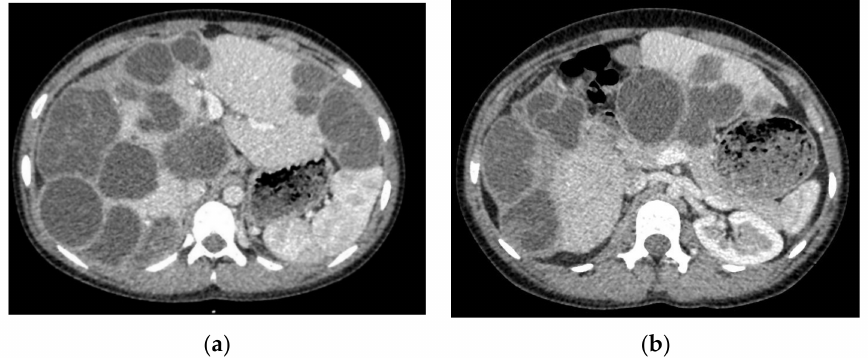
Figure 5. Abdominal CT Scan with IV contrast. ( a , b ) multiple liver cystic lesions with small areas of normal parenchyma.